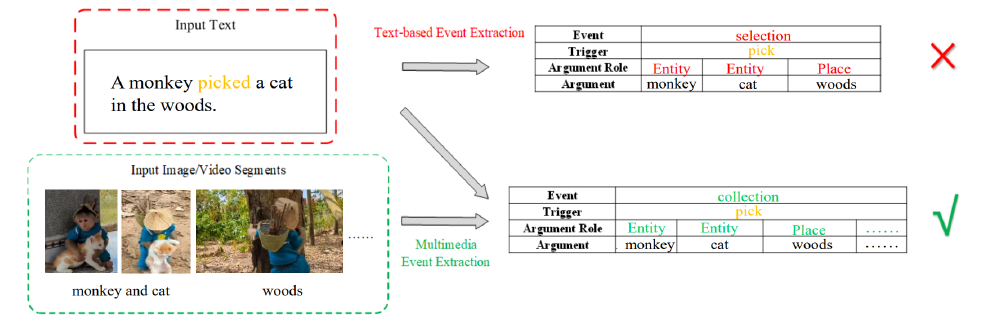
Figure 6. Illustration of multimodal event